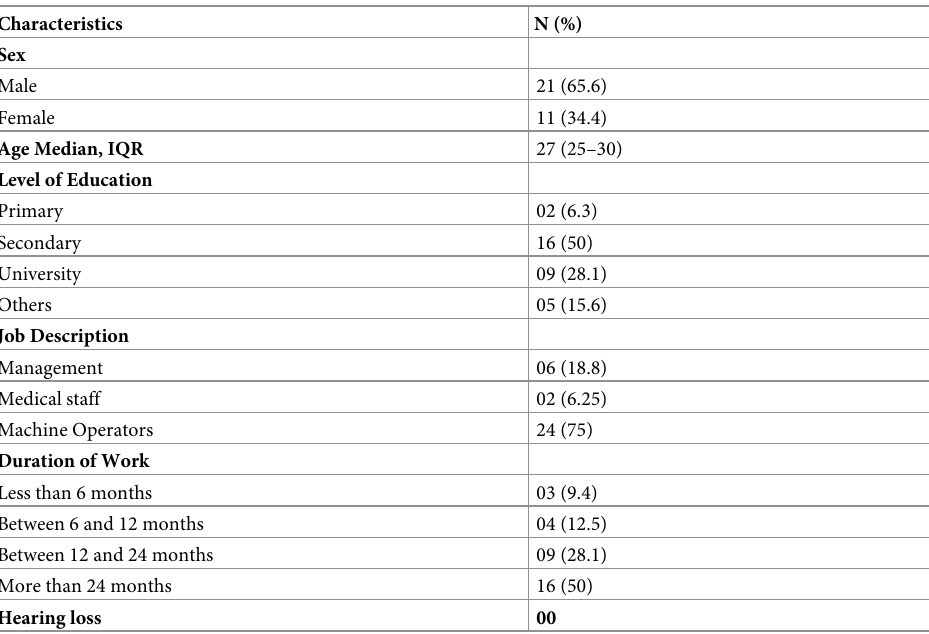
Table 1. Socio-demographic characteristics of the